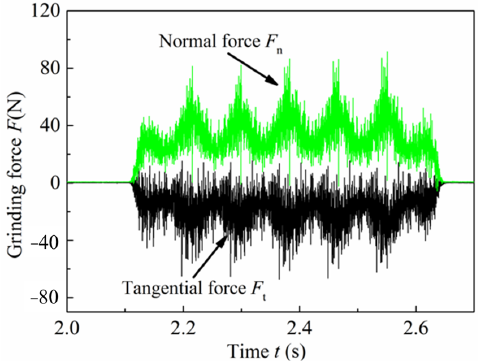
Figure 4. The typical grinding force signals without filtering.